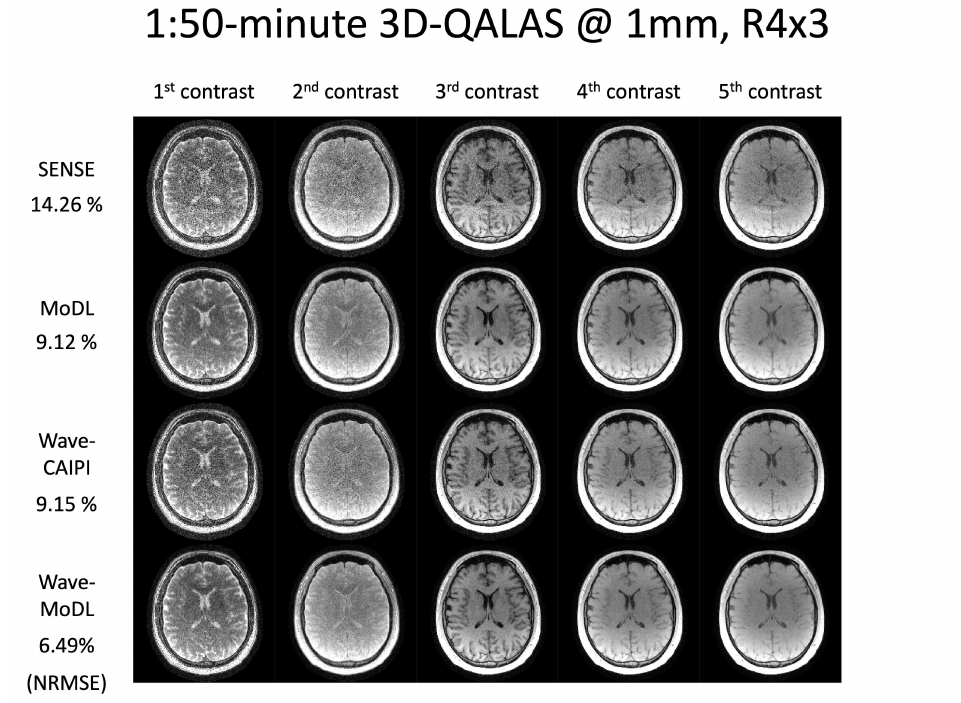
Figure 5. Multicontrast image reconstruction using SENSE, MoDL, wave-CAIPI, and wave-MoDL. The results are 1:50 min scans at R = 4 × 3 and 1 mm isotropic resolution.